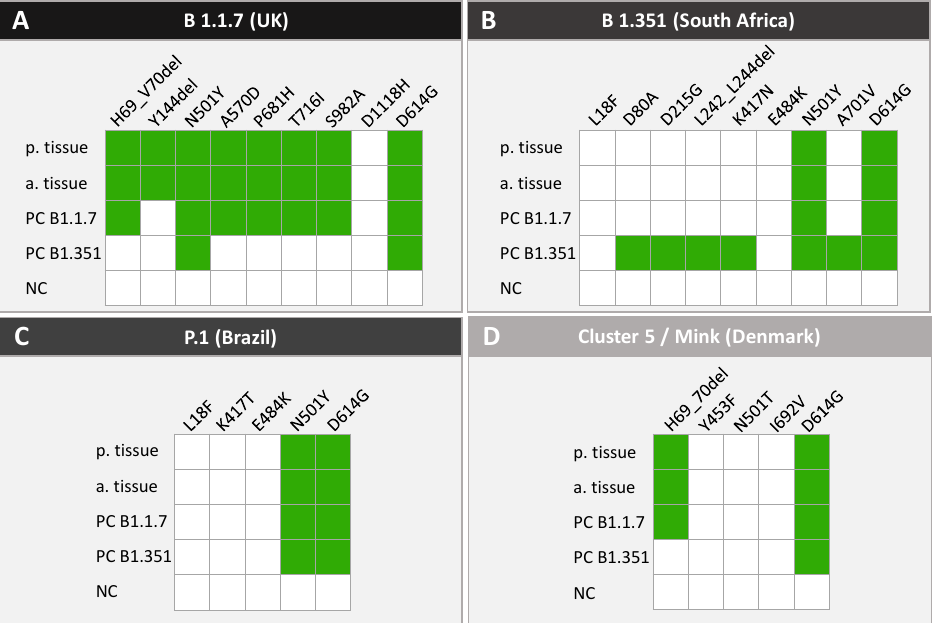
Figure 5. SARS-CoV-2 variant analysis of amniotic and placental tissue by MALDI-TOF MS. Placental and amniotic tissue were analyzed by MALDI-TOF MS using the MassARRAY SARS-CoV-2 Variant Panel v1. The figure shows the specific mutations within the SARS-CoV-2 spike gene that are assigned to the different variants B 1.1.7 ( A ), B 1.351 ( B ), P.1 ( C ) and Cluster 5/Mink ( D ). Detected mutations in placental tissue (p.tissue), amniotic tissue (a.tissue), positive controls (PC) B 1.1.7 and B 1.351 and negative control (NC) are illustrated by green-colored squares.